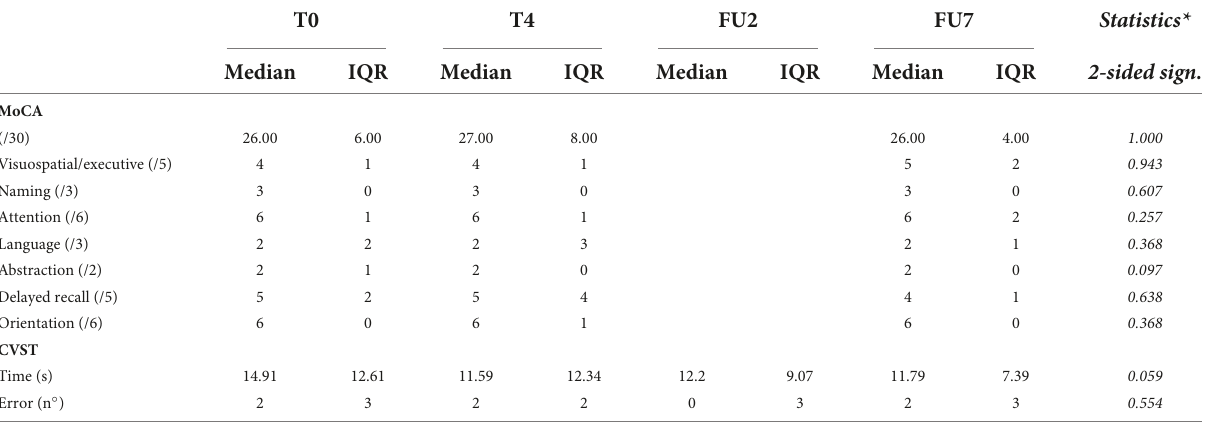
TABLE 4 Cognitive